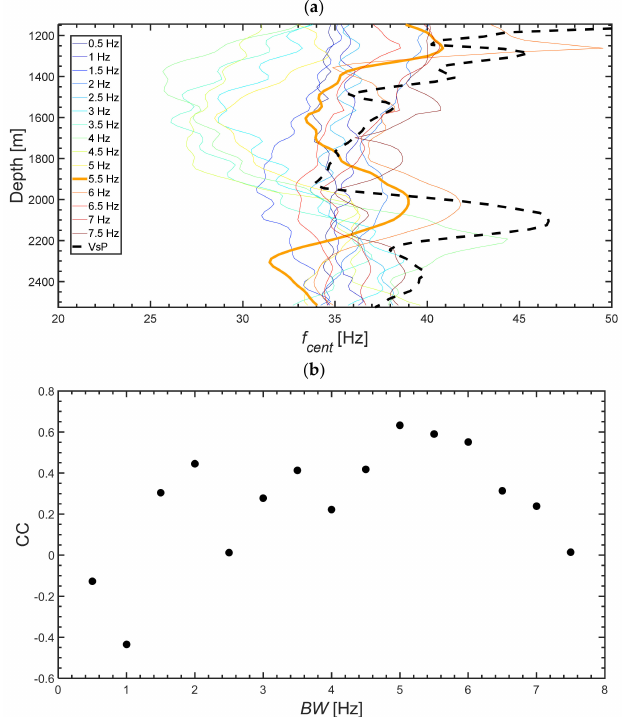
Figure 8. Centroid frequencies of: ( a ) OBC seismic spectra obtained at different values of the filter width ( BW ) (solid curves) and VSP spectrum (dashed curve), centroid frequency curves of VSP and BW = 5.5 Hz are highlighted by thick lines; ( b ) coefficient of cross-correlation between OBC and VSP centroid frequency curves at different values of